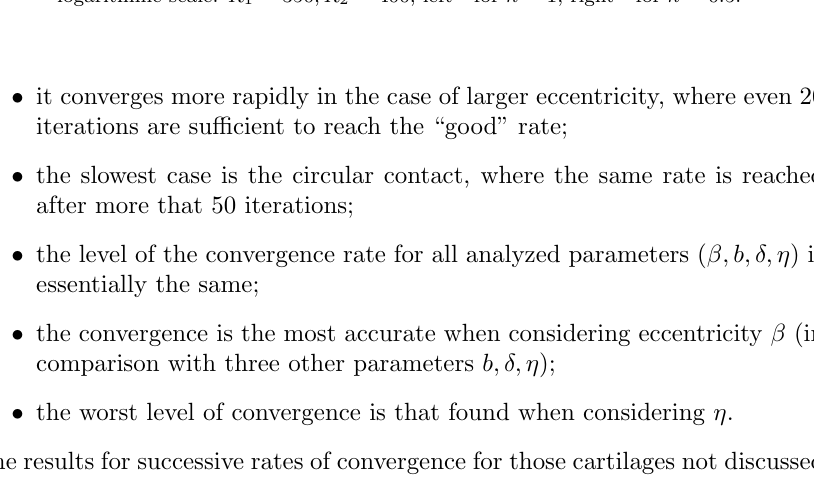
Figure 3. Successive rate of the convergence for the parameters in standard and logarithmic scale. R 1 = 350 ,R 2 = 400, left - for h = 1, right - for h = 0 .